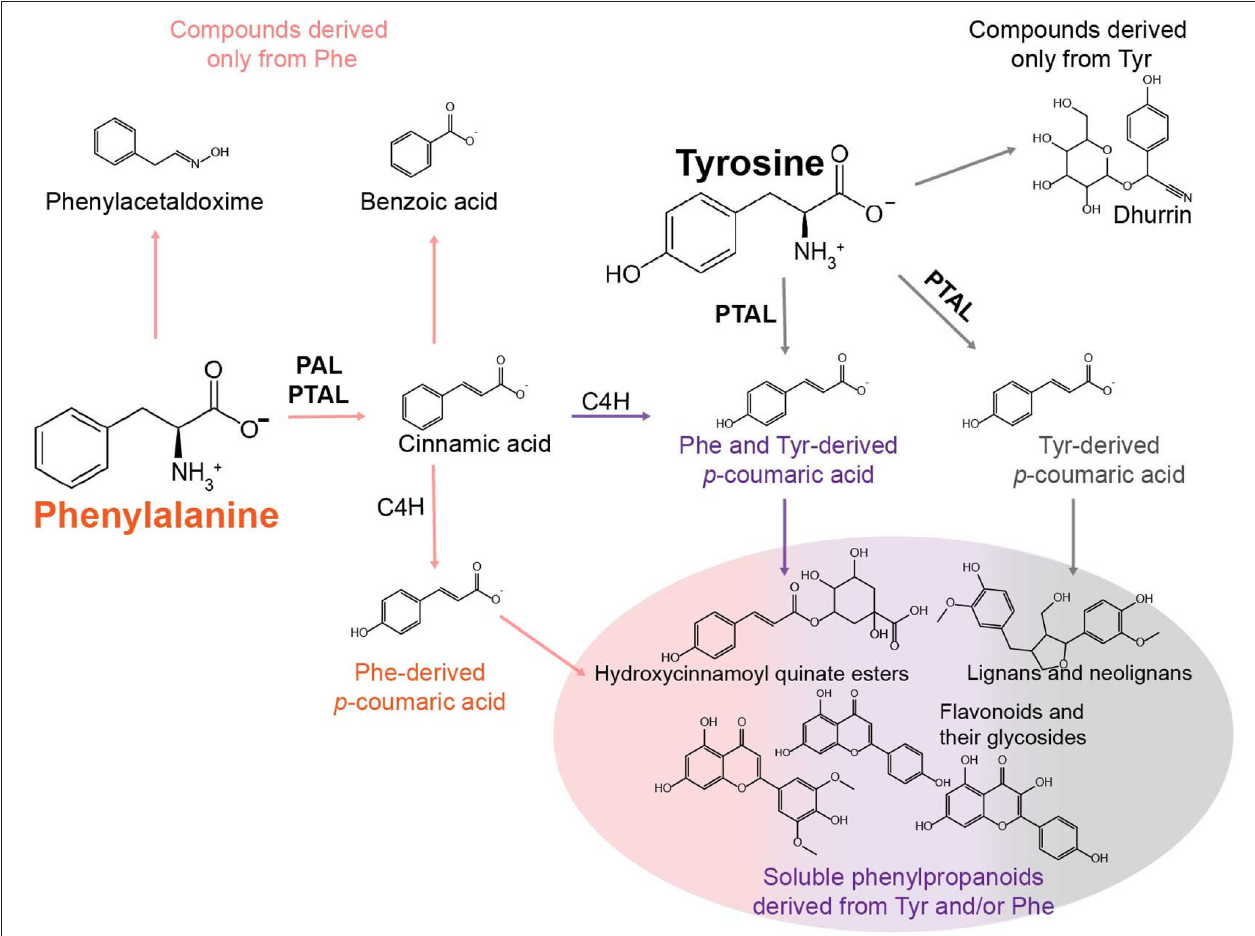
FIGURE 1 | Model describing some of the metabolic fates of Phe and Tyr in phenylalanine/tyrosine ammonia-lyase (PTAL)-containing grasses. The primary fate of Phe is conversion to cinnamic acid by phenylalanine ammonia-lyase (PAL) or PTAL. Cinnamic acid can then be hydroxylated into p- coumarate by cinnamate 4-hydroylase (C4H) or converted to metabolites that are not p -hydroxylated (e.g., benzoic acid). Phe may also enter other pathways devoted to the production of phenylacetic acid via phenylacetaldoxime or phenylethanol. In sorghum, the primary fates of Tyr are the conversion into p -coumaric acid by PTAL or metabolism to the cyanogenic glycoside dhurrin. The different colored arrows leading to and from p -coumaric acid structures are meant to illustrate the multiple p -coumaric acid pools that can be derived from Phe via PAL, Phe via PTAL (orange), Phe and Tyr via PTAL (purple), and Tyr via PTAL (gray). Each of these pools may be utilized in different ways to produce downstream soluble